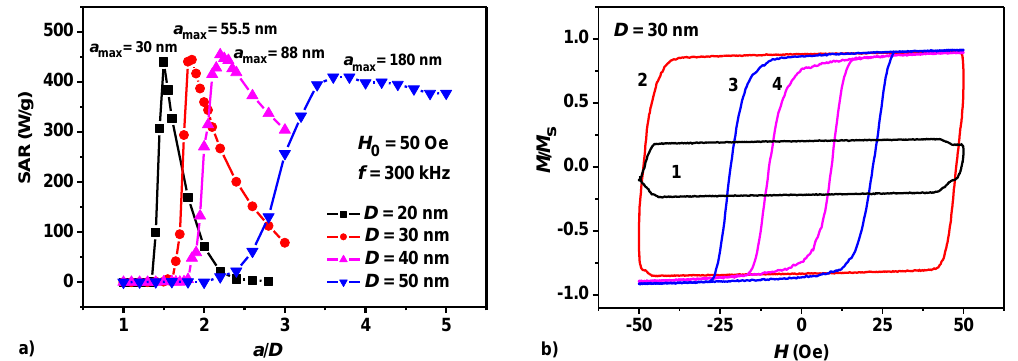
Figure 1 . ( a ) Dependence of assembly SAR on the reduced distance a / D between the particle centers for chains with various particle diameters. ( b ) Evolution of the shape of the low-frequency hysteresis loop for chains of particles with diameter D = 30 nm for various reduced distances: (1) a / D = 1.7, (2) a / D = 1.85, (3) a / D = 2.4, (4) a / D = 3.0.